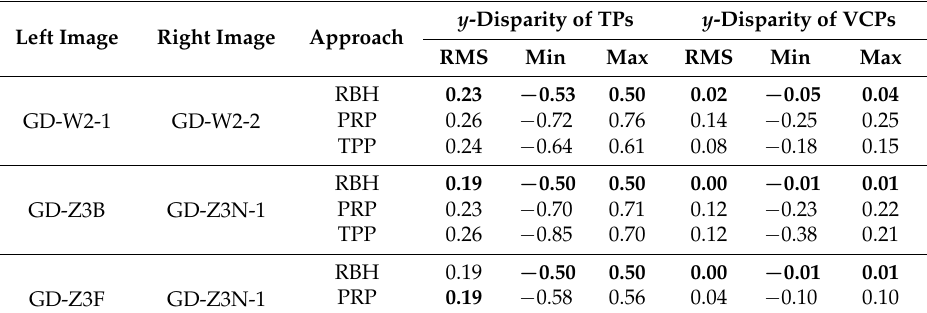
Table 3. The results of the image pairs in along-track stereo